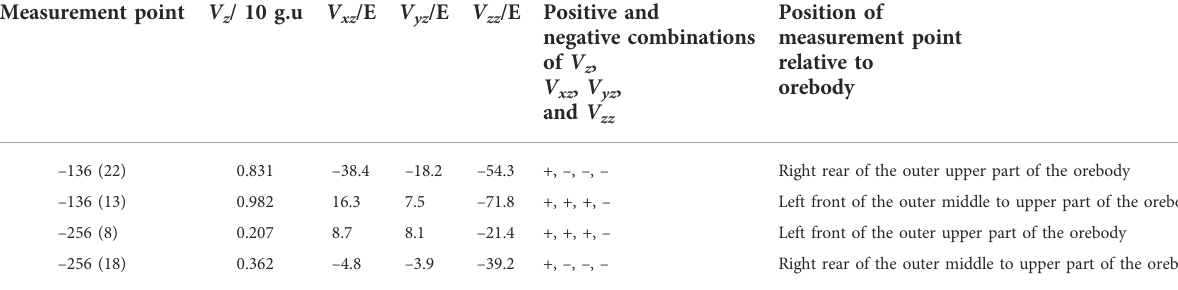
TABLE 3 Positive and negative combinations of V z , V xz , V yz , and V zz and the relative positions of the orebody in the middle section of the Huangshaping mining area ( − 136 and − 256 m).